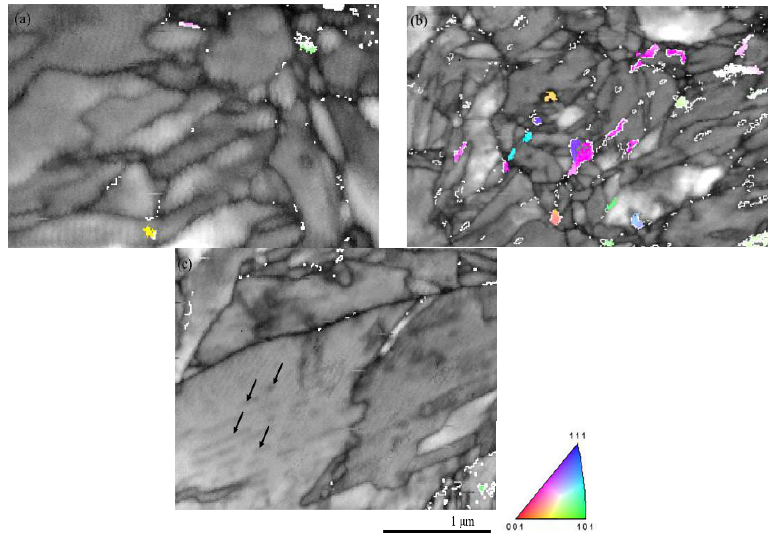
Figure 5. Virtual bright field (VBF) images superimposed on the IPF map of austenite in the ( a ) surface WEL; ( b ) central WEL; ( c ) interface WEL. Austenite grains are colored according to the IPF scheme. The black arrows indicate the possible untransformed cementite. The same scale is used for all the images.